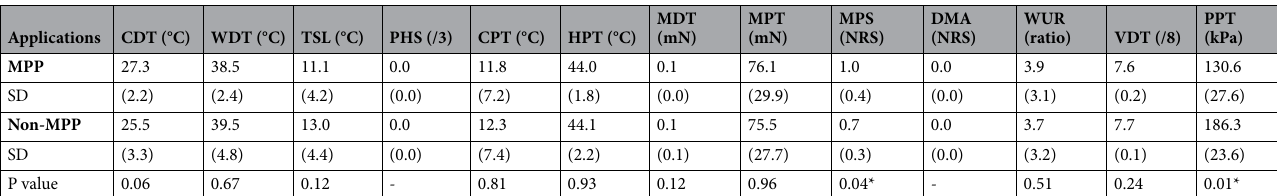
Table 1. Comparison of quantitative sensory testing (QST) results between masseter muscle pain prone (MPP) group and non-masseter muscle pain prone (non-MPP) group for masseter muscle. All data are presented as mean and standard deviations of the mean. CDT = cold detection threshold (°C) ; WDT = warm detection threshold (°C) ; TSL = thermal sensory limen (°C) ; PHS = paradoxical heat sensation (score/3) ; CPT = cold pain threshold (°C) ; HPT = heat pain threshold (°C) ; MPT = mechanical pain threshold (mN) ; MPS = mechanical pain sensitivity (mean pain rating, 0–100) ; DMA = dynamic mechanical allodynia